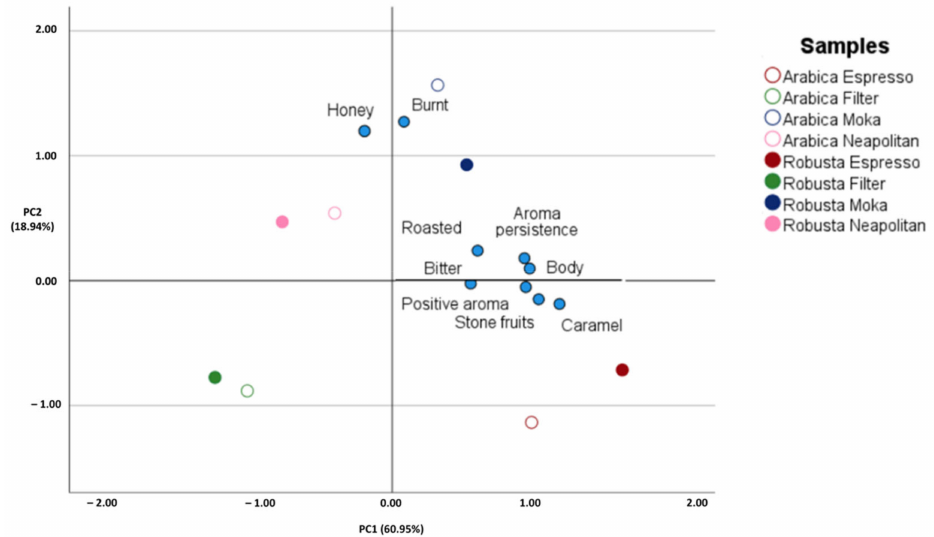
Figure 4. Unsupervised PCA score plot resulted from data obtained by sensory analysis of dif- ferent coffee beverage corresponding to four extraction systems applied on Arabica and Robusta roasted